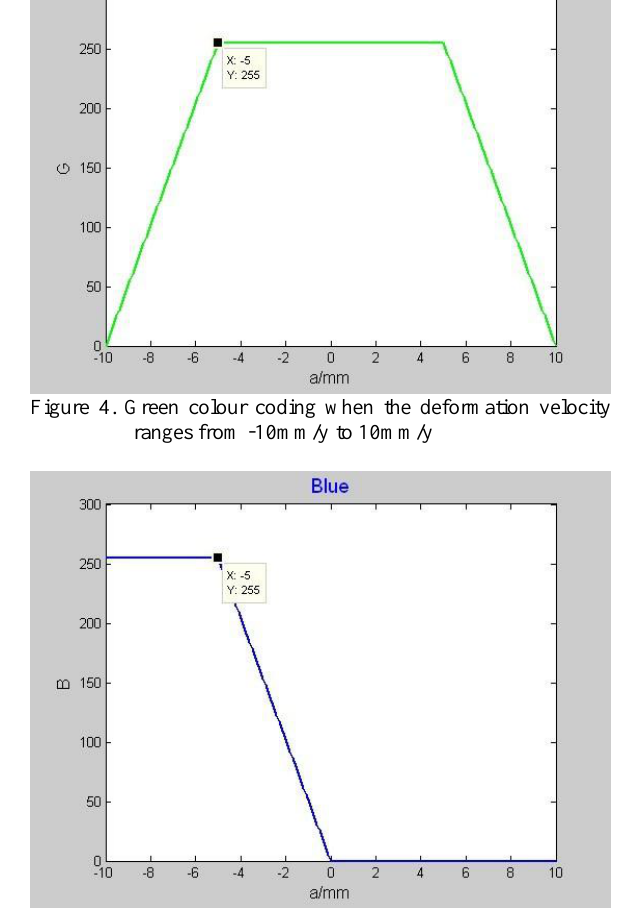
Figure 5. Blue colour coding when the deformation velocity ranges from -10mm/y to 10mm/y A common method to visualize four-dimensional data is colour coding. In our case study, the velocity information is coded as colour information. The following functions are used to implement the colour